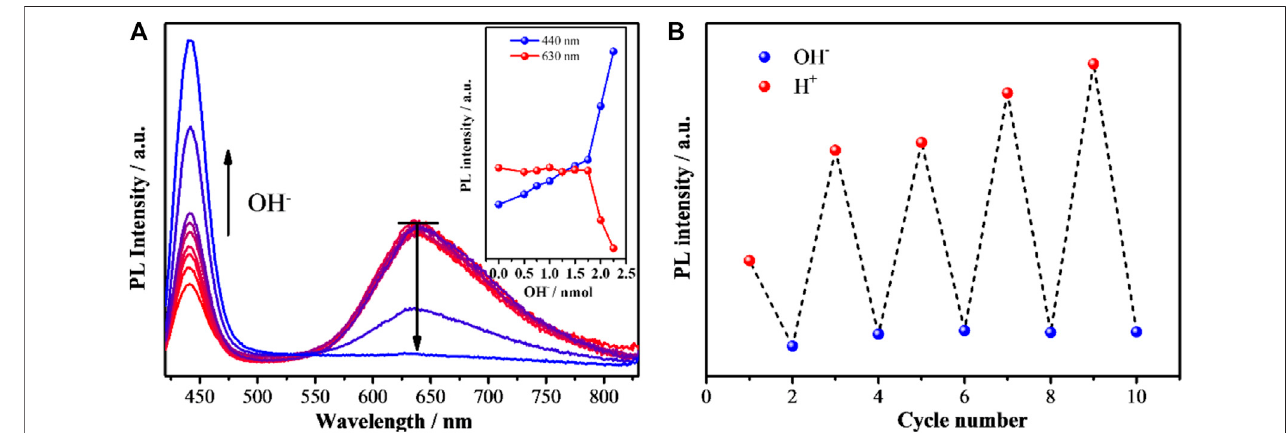
FIGURE3 |(A) Photoluminescencespectra ofas-synthesized Ag 1 Au@DT NCs after adding increasing amounts of 50 mm NaOH aqueous solution. Fluorescence spectra weremeasured at λ ex (cid:2) 320 nm.The insetdisplaysthe relationship betweenphotoluminescence (440 nm and 630 nm)intensity and the addedmoleamount of NaOH. (B) PL intensity of Ag 1 Au@DT NCs upon cyclic switching of the pH by adding 50 ul 50 mM NaOH and 50 ul 50 mm HCl aqueous